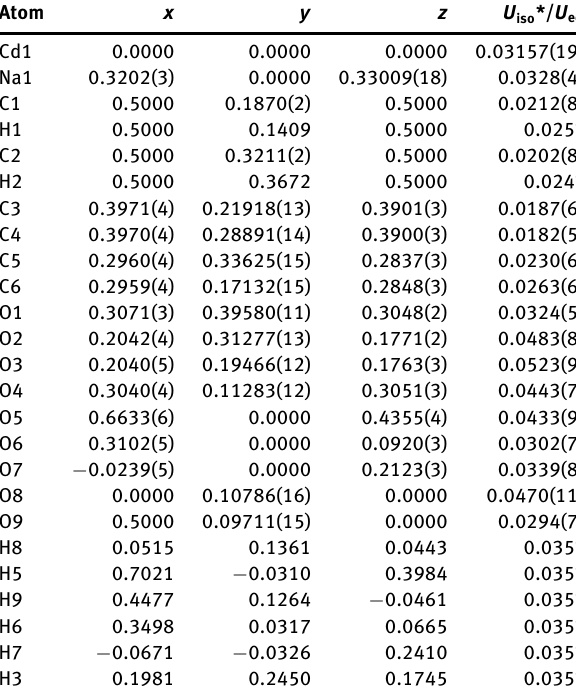
Table 2: Fractional atomic coordinates and isotropic or equivalent isotropic displacement parameters (Å 2